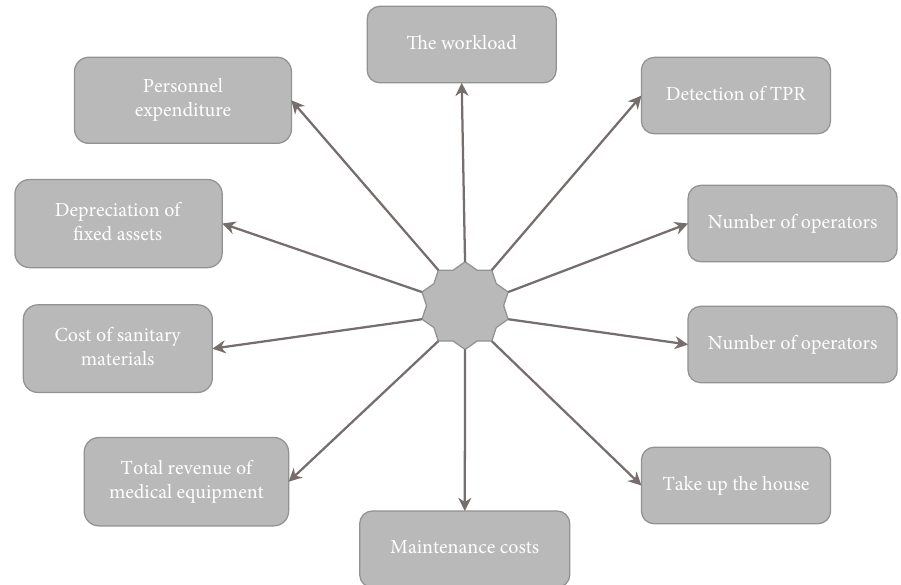
Figure 2: Details of data information